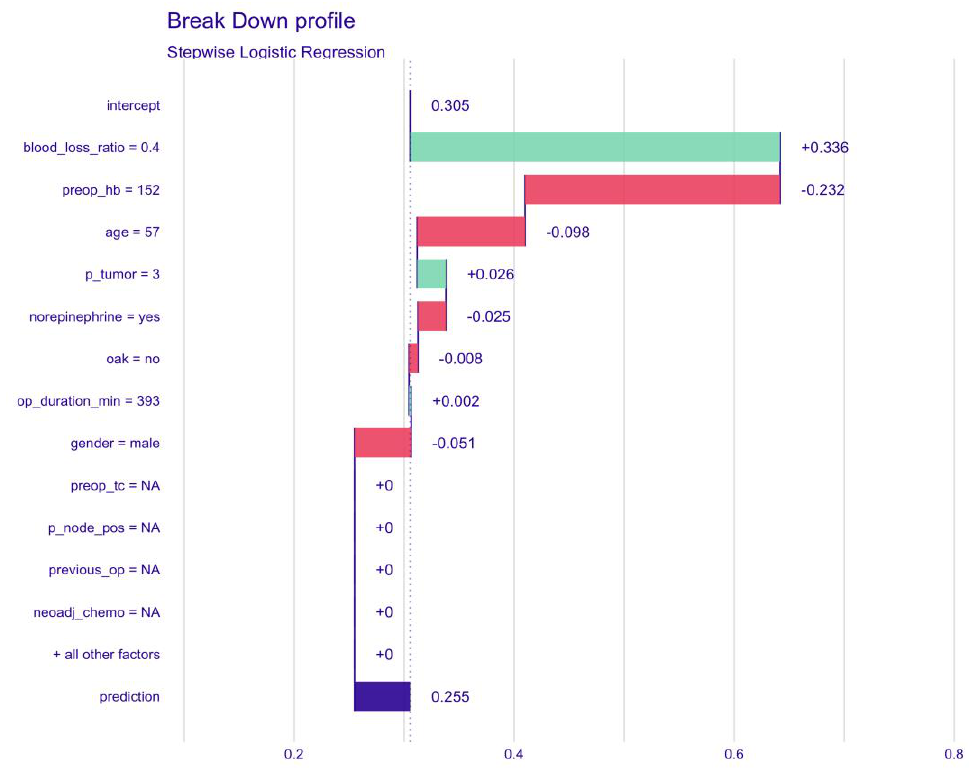
Figure A7. Younger male patient with higher hemoglobin levels and higher blood loss (p trans =